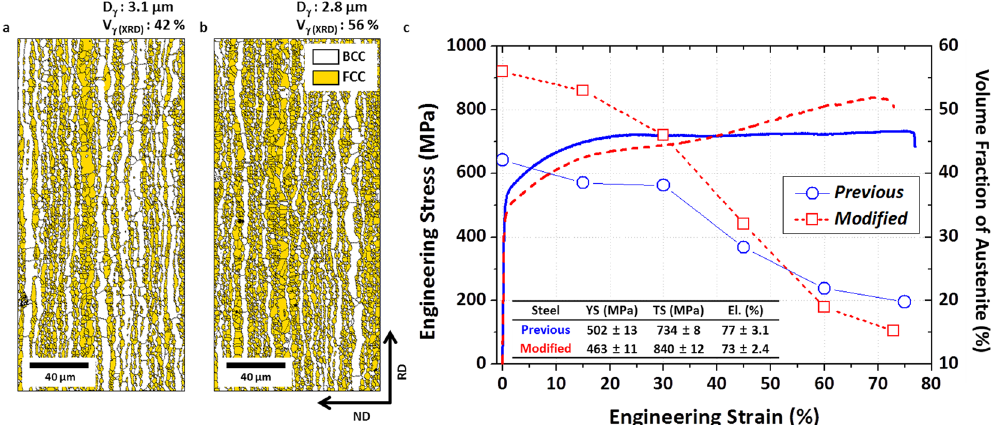
Figure 2. Microstructures and tensile properties of previous and modified steels. ( a,b ) EBSD phase map. ( c ) room temperature tensile stress-strain curves. The austenite grain sizes are similar (about 3 μ m), but the austenite fraction is higher in the modified steel (56%). The previous steel shows a steady stress flow behavior after the strain of 30% without a large strain hardening, whereas the modified steel shows a continuous strain hardening after the strain of 25%. Thus, the modified steel has the higher tensile strength (840 MPa) than the previous steel, while the elongation is almost same. Both steels were cold-rolled with reduction ratio of 66%, and were annealed at 900 °C for 30